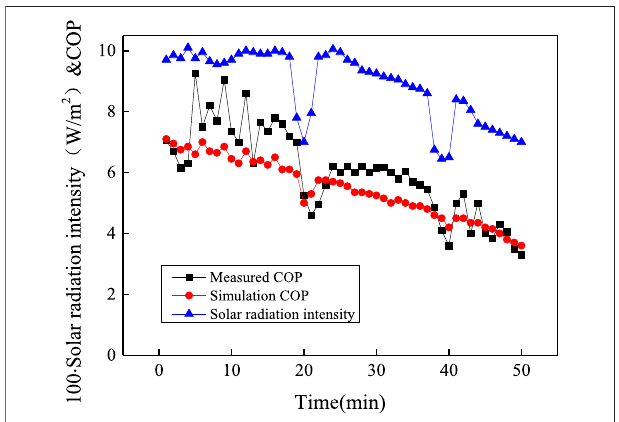
FIGURE 1 | Comparison of predicted and experimental values of COP and operation time.